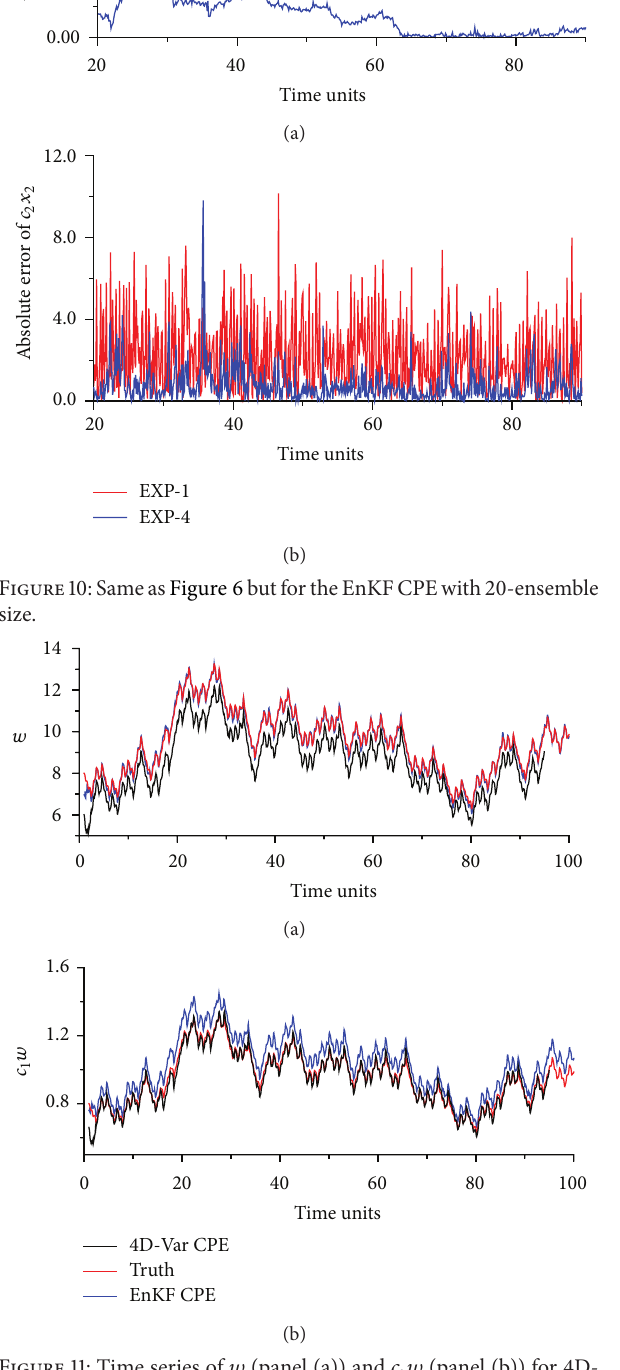
Figure 11: Time series of 𝑤 (panel (a)) and 𝑐 1 𝑤 (panel (b)) for 4D- Var CPE (black) with MTW being 500 time steps, truth (red), and EnKF CPE (blue) with ensemble size being 50 in EXP-4. Here, the observational interval is set to 5 time steps.